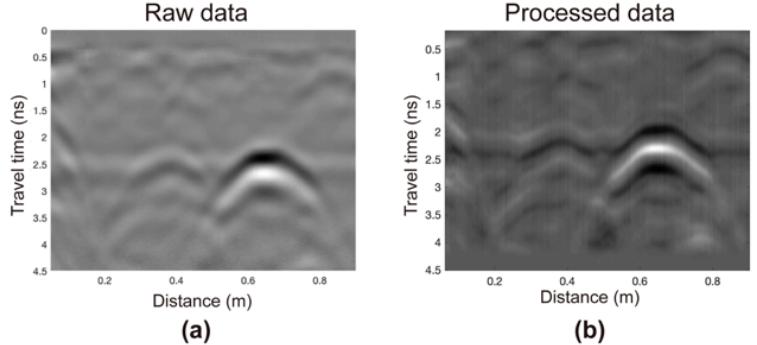
Figure 2. ( a ) Acquired B-scan (raw data) obtained in the laboratory model. ( b ) Processed B-scan using conventional flow (correction of the surface position, deconvolution and IRR filters). The standard processing does not remove the clutter reflections corresponding to the disperse elements of the lab soil.